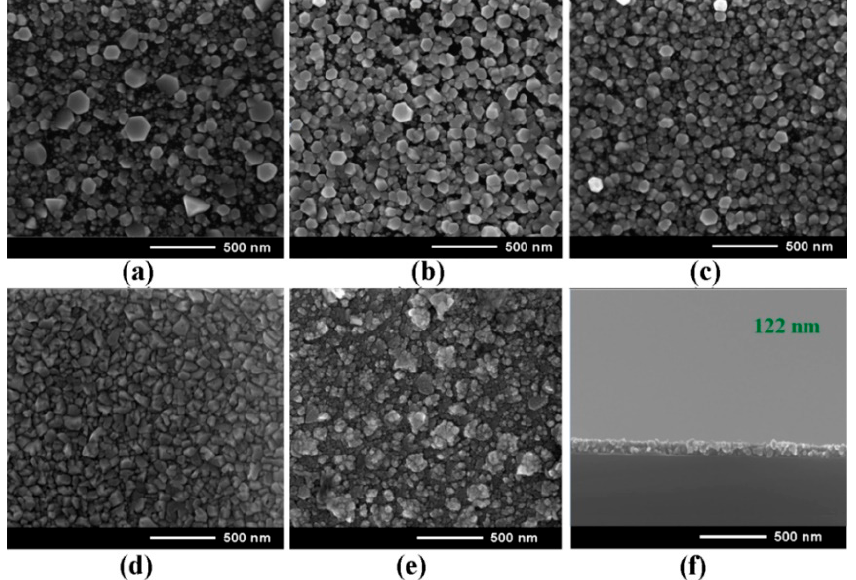
Figure 3. SEM images of Zn 1 − x Mg x O alloy films deposited by spin coating and subjected to annealing at 500 °C during 1 h. The x -values of the films: 0 ( a ); 0.2 ( b ); 0.4 ( c ); 0.6 ( d ); 0.8 ( e ). The SEM image in cross section of a film with x = 0.4 is shown in ( f ). Table 1. Chemical composition, according to the EDX-analysis, of the Zn 1 − x Mg x O alloy films deposited by spin